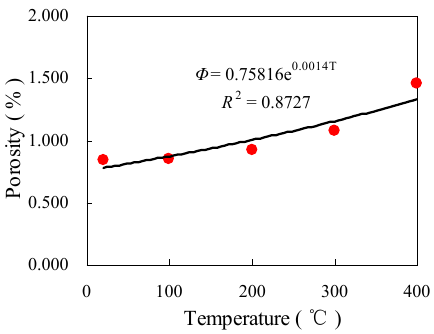
Figure 8. Porosity of granite under different temperatures.